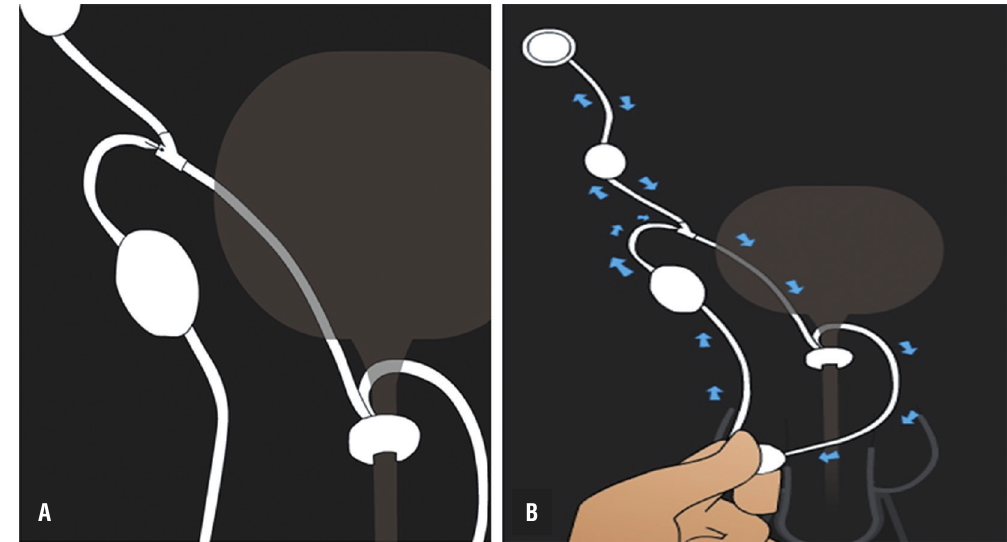
Figure 2 - A) Pressure reducing system and B) Operating system. The resting device maintains urethral compression preserving urinary